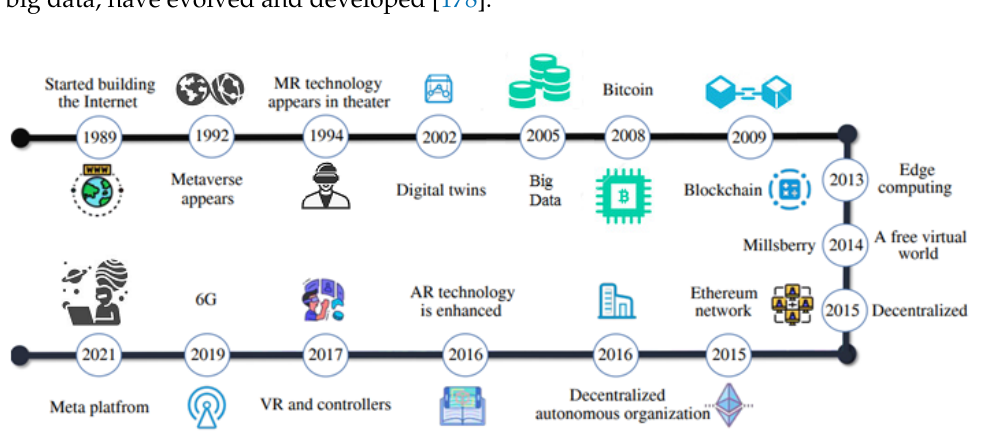
Figure 12. Big data plays a key component in both the physical world and virtual worlds. The Metaverse is a virtual world parallel to the real physical world: the two are sometimes connected by augmented reality and digital twin. The current definitions of the Metaverse vary according to different studies; how- ever, many researchers share a common view that the Metaverse is imitating our physical world. In this survey, the authors believe that future virtual worlds, including the Metaverse, will develop to be totally different world from our physical world: these vir- tual worlds will go beyond our current social structure and civil life. Table 3 shows the example applications of the Metaverse and big data in several key sectors. Table 3. A brief review of example applications of big data and the Metaverse in major sectors. Sectors